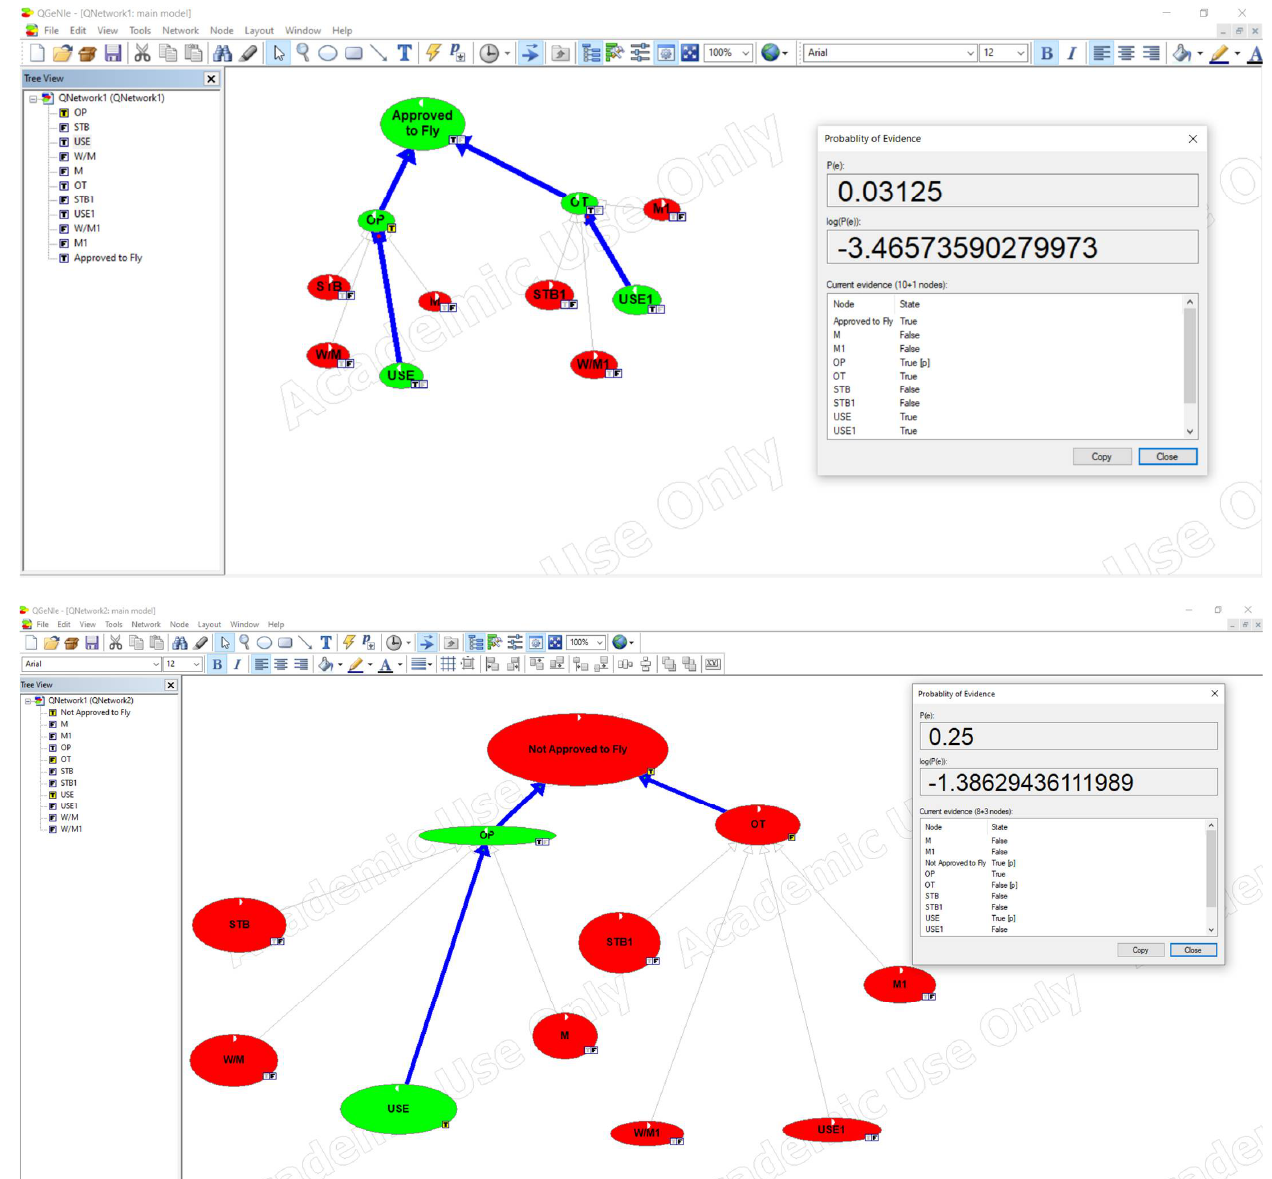
Figure 6. Selected results (optimization of possible strategies (OP) and (TO) from the matrix (Cxj)) with use of QGeNie Modeller.